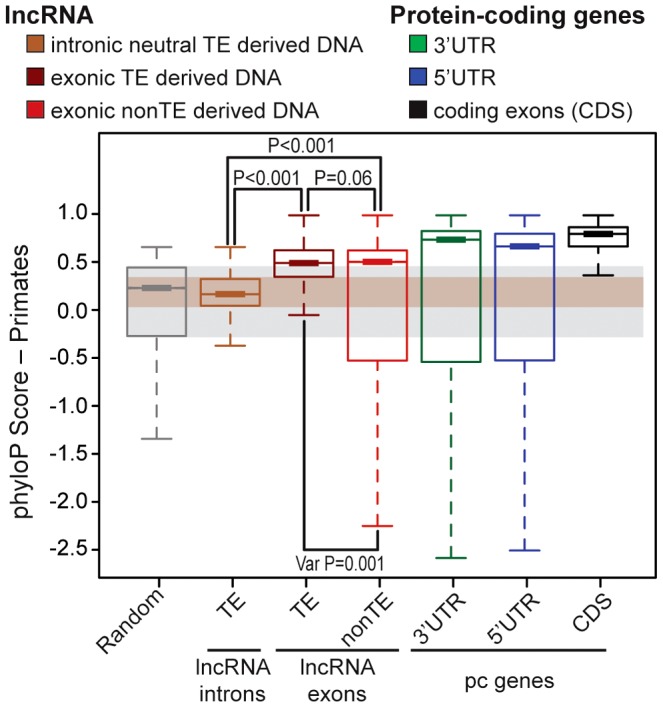
Evidence of purifying selection in TE–derived DNA transcribed as lncRNAs.LncRNAs correspond to Gencode v13 (human) and protein coding genes to Refseq 57 (human, 20,848 genes). Boxplots show primate PhyloP scores computed in order to compare the conservation of different sets (see upper panel). Random set is size and number-matched for TE-derived DNA in lncRNA exons. Intronic lncRNA TEs correspond to TE-derived DNA in lncRNA introns that don't overlapp with splicing sites and all annotated chromatin marks were removed (see Methods), in order to obtain a most neutral set [inactive chromatin, see 32]. Statistical test used: permutation test with 1000 permutations were performed in R. Boxplots depicts the median upper (75%) and lower (25%) quantiles. The whiskers extend beyond the upper and lower quantile by 1.5× the inner quartile range. Outliers have been removed for visualization.